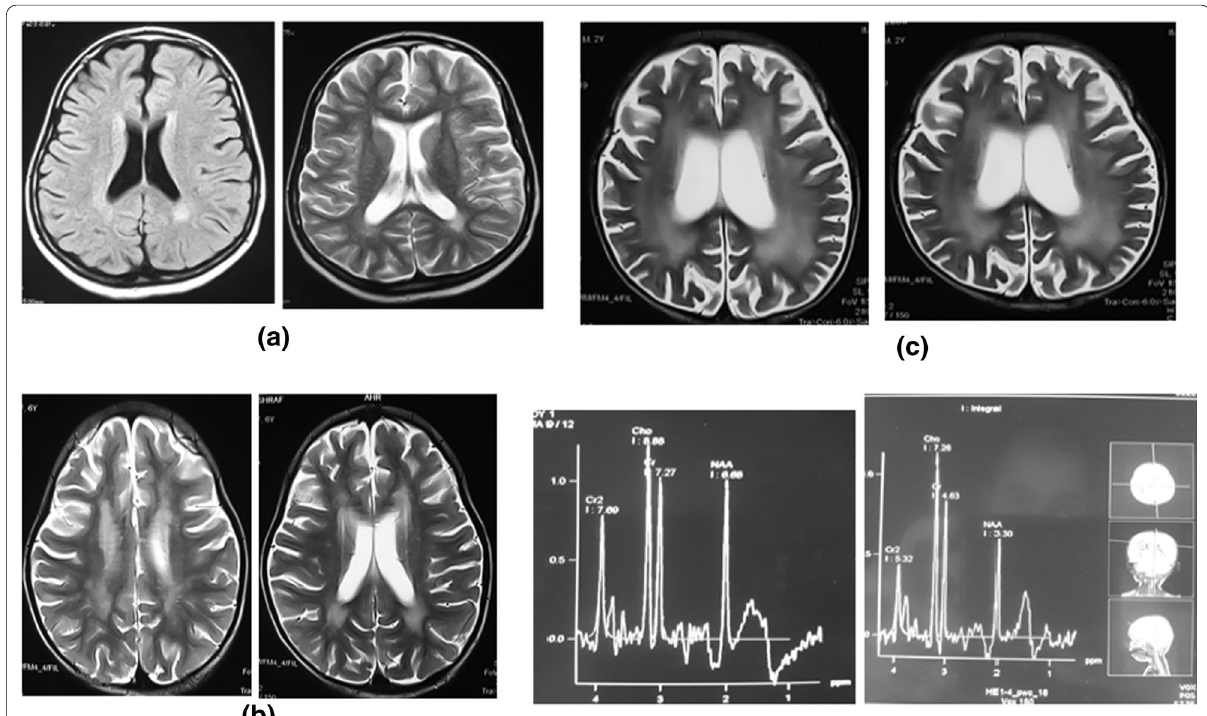
Fig. 1 Magnetic resonance imaging and magnetic resonance spectroscopy of sibling 1. a Sibling 1: 12 year female. Axial FLAIR and T2W images. Bilateral symmetrical white matter hyperintensities in peri-ventricular and peritrigonal white matter. b Sibling 2. 06 year female: Axial T2W image— bilateral increased white matter intensities in centrum semi-ovale and peritrigonal white matter. Ventricular and extra-ventricular CSF spaces are prominent. c Sibling 5: 2.5 years male—axial T2W images: bilateral symmetrical increased white matter intensities with mild hydrocephalus. MRS multi-voxel technique. Increased Choline peak with abnormal Choline creatine ratio favors demyelinating